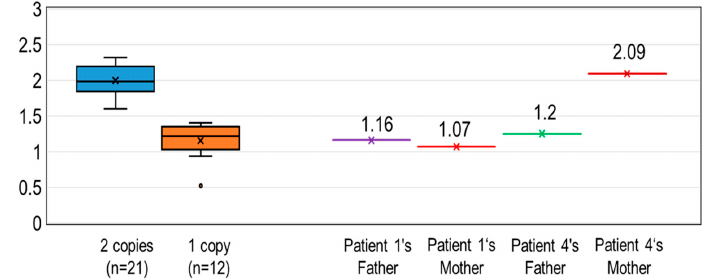
Figure 4. Calculated SMN1 copy number values using DBS on Guthrie cards. Box-and-whisker plots of the calculated copy number values were obtained from 21 DBS samples with two SMN1 copies and 12 DBS samples with one SMN1 c opy. Patient 1’s parents and Patient 2’s father carried one SMN1 copy, but Patient 2’s mother carried two SMN1 copies. The x mark indicates the average value of each